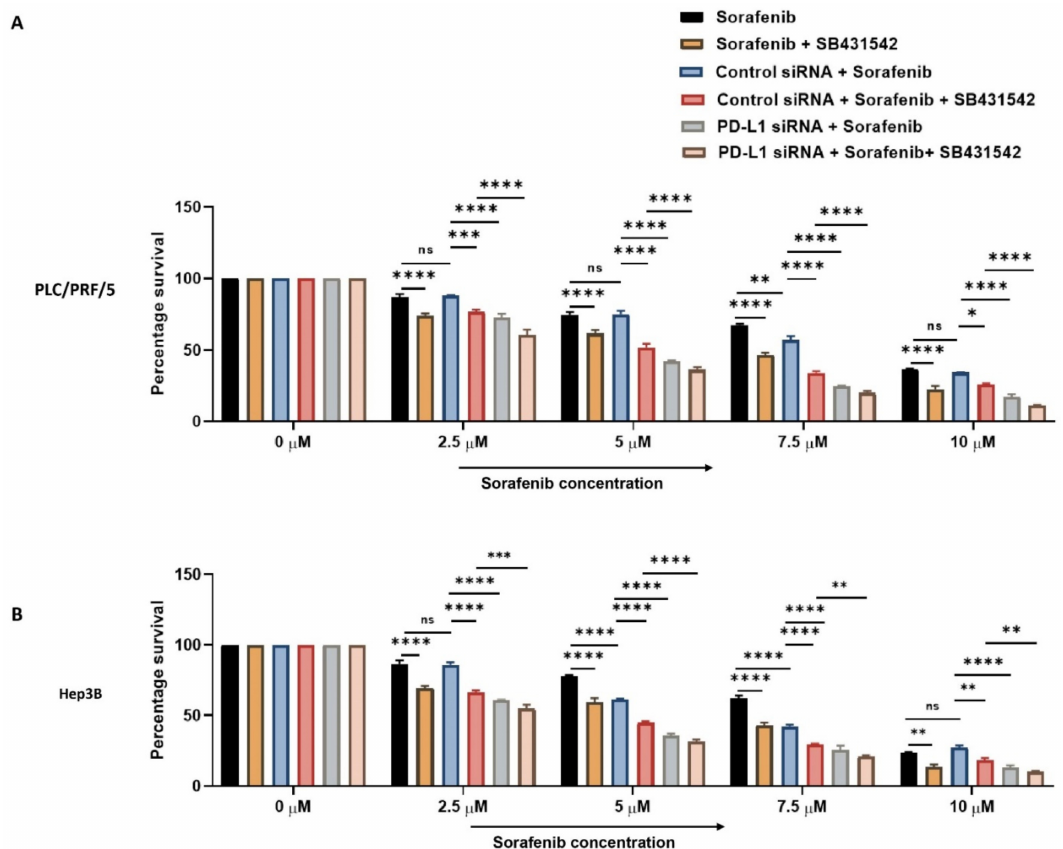
Figure 9. Combination treatment of PD-L1 knockdown with SB431542 can overcome Sorafenib resistance in HCC cells. Cell viability assay revealed that percentage survival of cells significantly reduced with the combination of increasing concentrations of Sorafenib with knockdown of PD-L1 and SB431542 compared to Sorafenib alone or Sorafenib with either SB431542 or PD-L1 knockdown or control siRNA treatment ( A ) PLC/PRF/5 and ( B ) Hep3B cells ( n = 3, * p < 0.05, ** p < 0.01, *** p < 0.005, **** p <